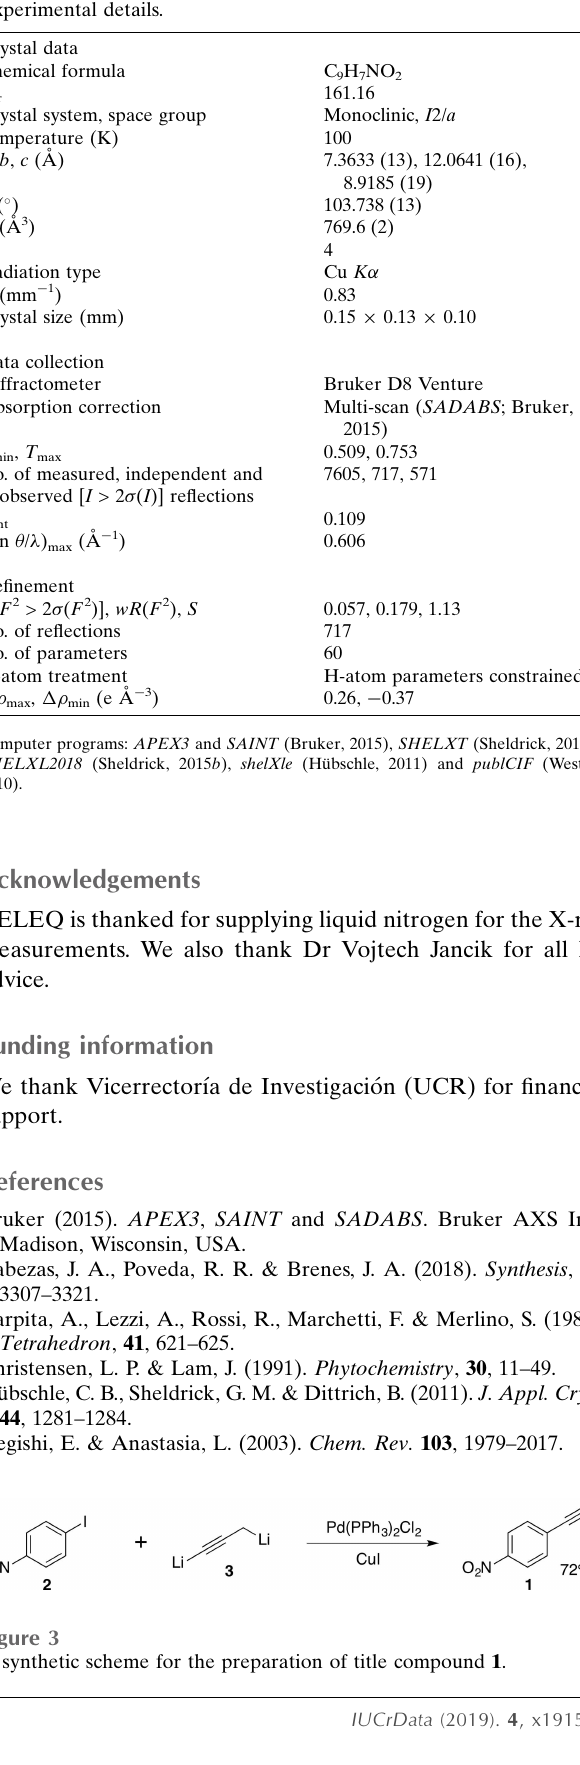
(cid:4) x , y , (cid:4) z . 2